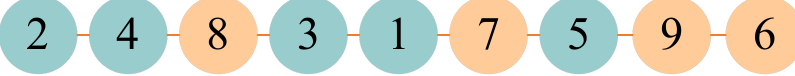
Fig. 6. New state after taking action